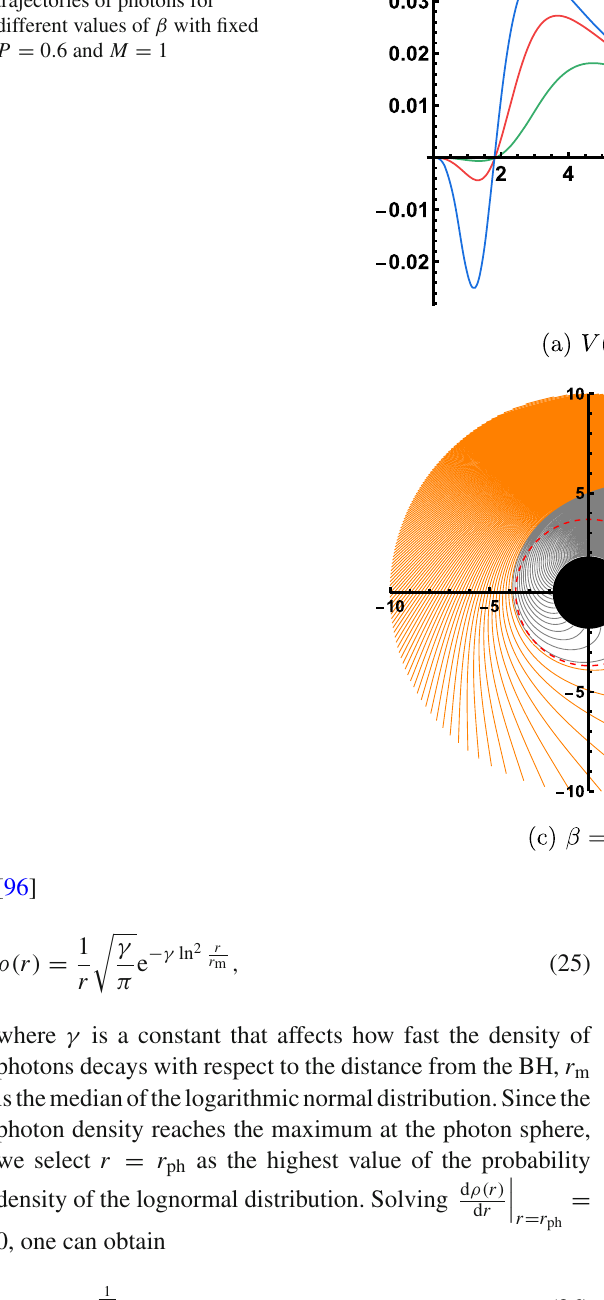
Fig. 3 The effective potential V ( r ) for different BI parameter β are shown in the top-left panel. The other figures are trajectories of photons for different values of β with fixed P = 0 . 6 and M =